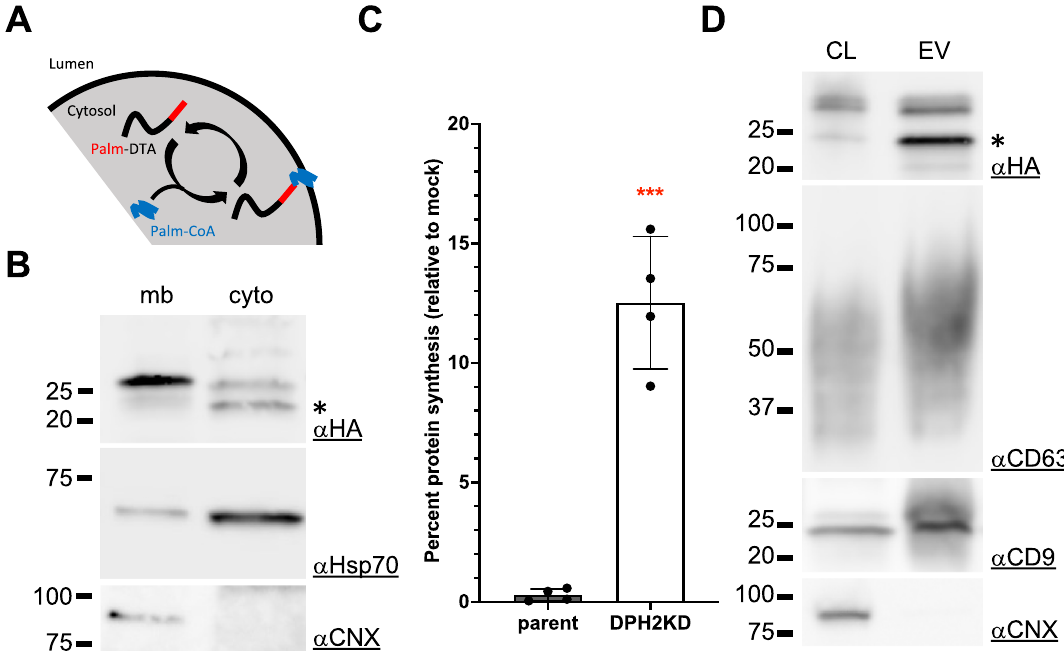
Figure 2. Palm-DTA loading into EVs. ( A ) Scheme of Palm-DTA association with membranes. ( B ) DPH2KD cells were transfected with a plasmid encoding Palm-DTA-HA and subjected to cytosol / membrane fractionation 36 h after transfection. *: de-palmitoylated form of the protein. ( C ) Parent or DPH2KD cells were co-transfected with NanoLuc-Hsp70 along with a mock plasmid or a plasmid encoding Palm-DTA-HA. 30 h post-transfection, the percentage of protein synthesis in cells co-transfected with a Palm-DTA-HA plasmid was calculated as the percentage of NanoLuciferase activity in these cells relative to mock-transfected cells. ***: p < 0.001. ( D ) EVs were prepared from DPH2KD cells transfected with a plasmid encoding Palm-DTA-HA. Total cell lysates (CL) and EV proteins were analyzed by western blot. The same amount of protein was loaded for each